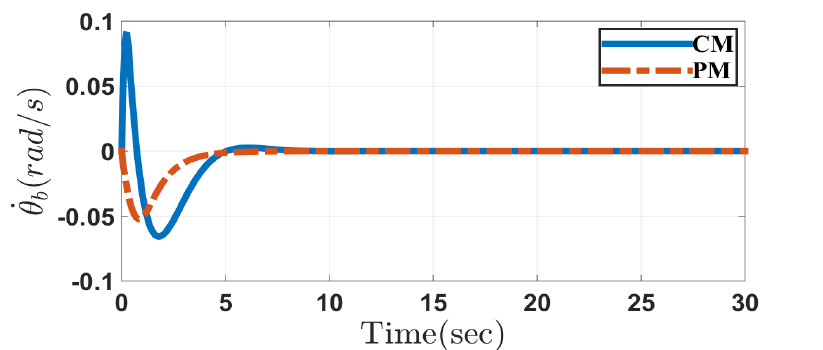
Figure 13. Pitch angular velocity of the system in the conventional method (CM) and the proposed method (PM) in Case 2.